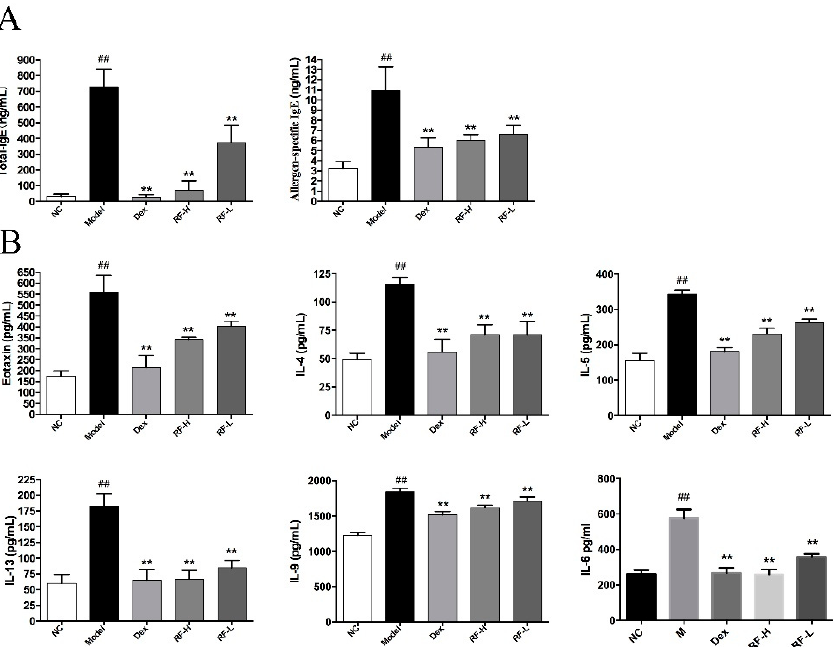
Figure 2. The effects of Renifolin F on cytokine production in serum and BALF. ( A ) The levels of total IgE and allergen-specific IgE in serum. ( B ) The levels of IL-4, IL-5, IL-13, IL-9 and IL-6 in BALF. Normal control, saline-induced mice only. Model, OVA-induced mice. Dex, OVA-induced mice treated with Dex (1.0 mg/kg). RF-H, OVA-induced mice treated with Renifolin F (3.0 mg/kg). RF-L, OVA-induced mice treated with Renifolin F (1.5 mg/kg). Statistics represented as the mean ± SEM ( n = 6). ## p < 0.01 vs. Normal control and ** p < 0.01 vs. Model.